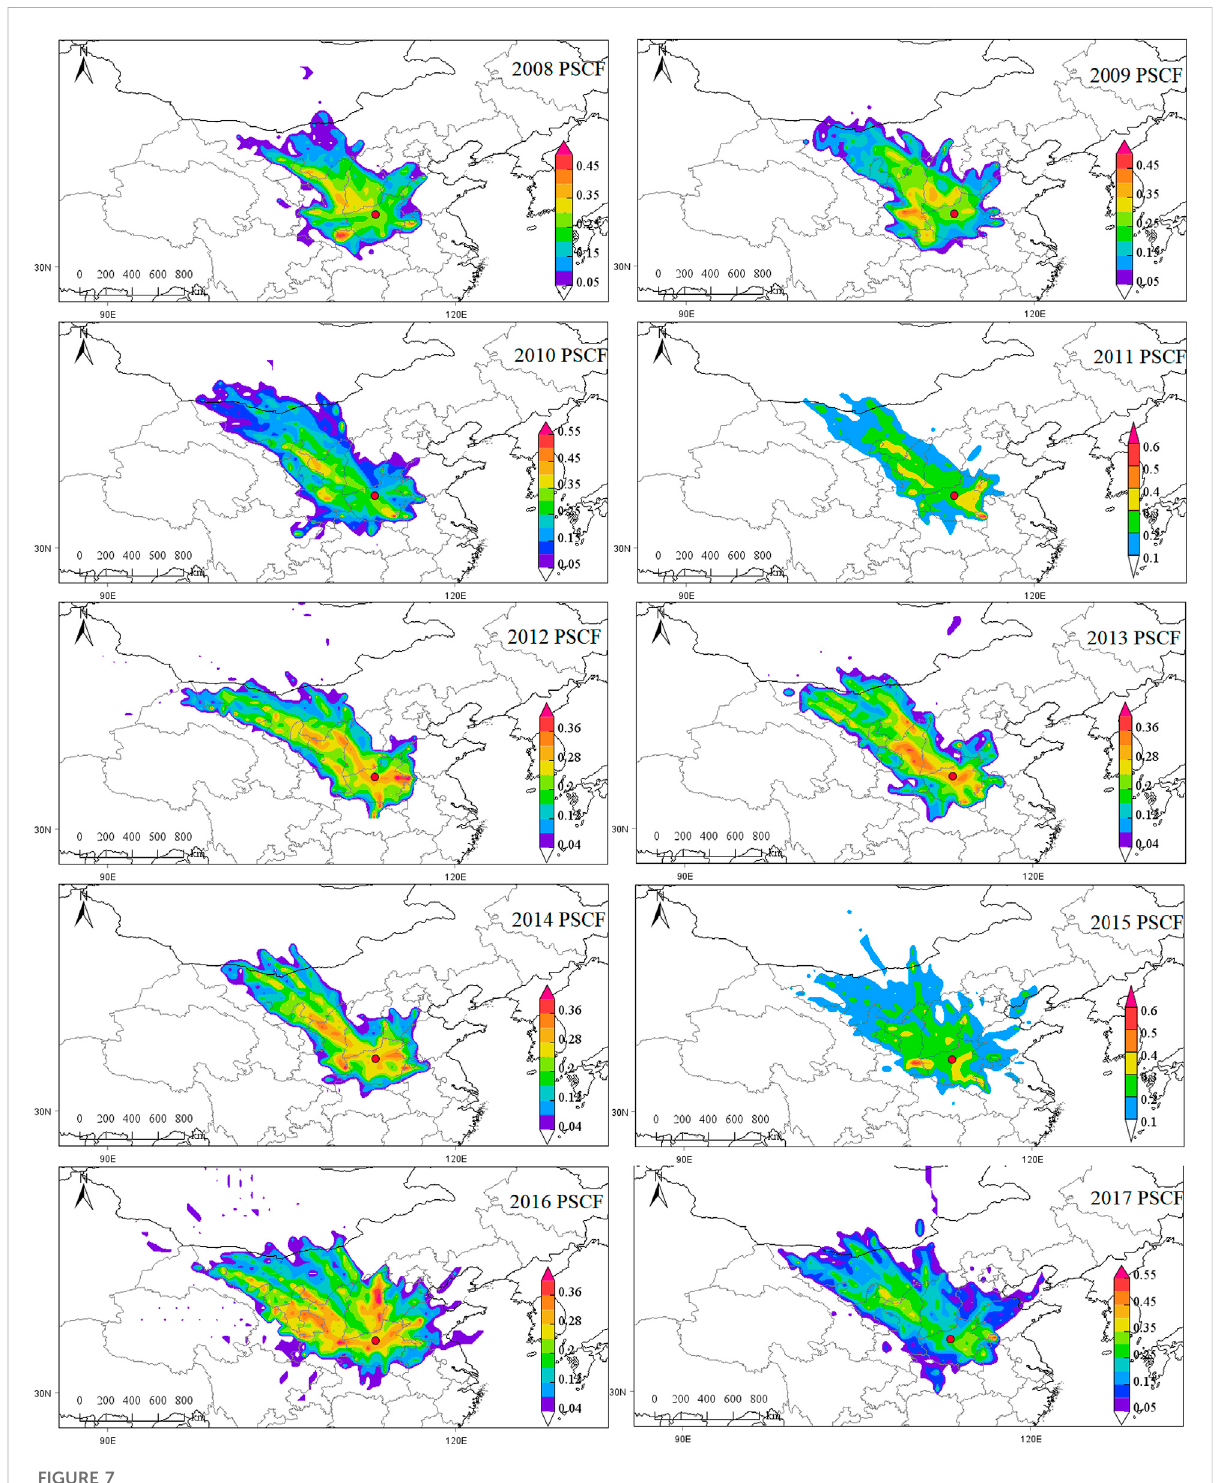
FIGURE 7 The potential source regions of BC in Zhengzhou from 2008 to 2017 based on the PSCF analysis ( μ g · m − 3